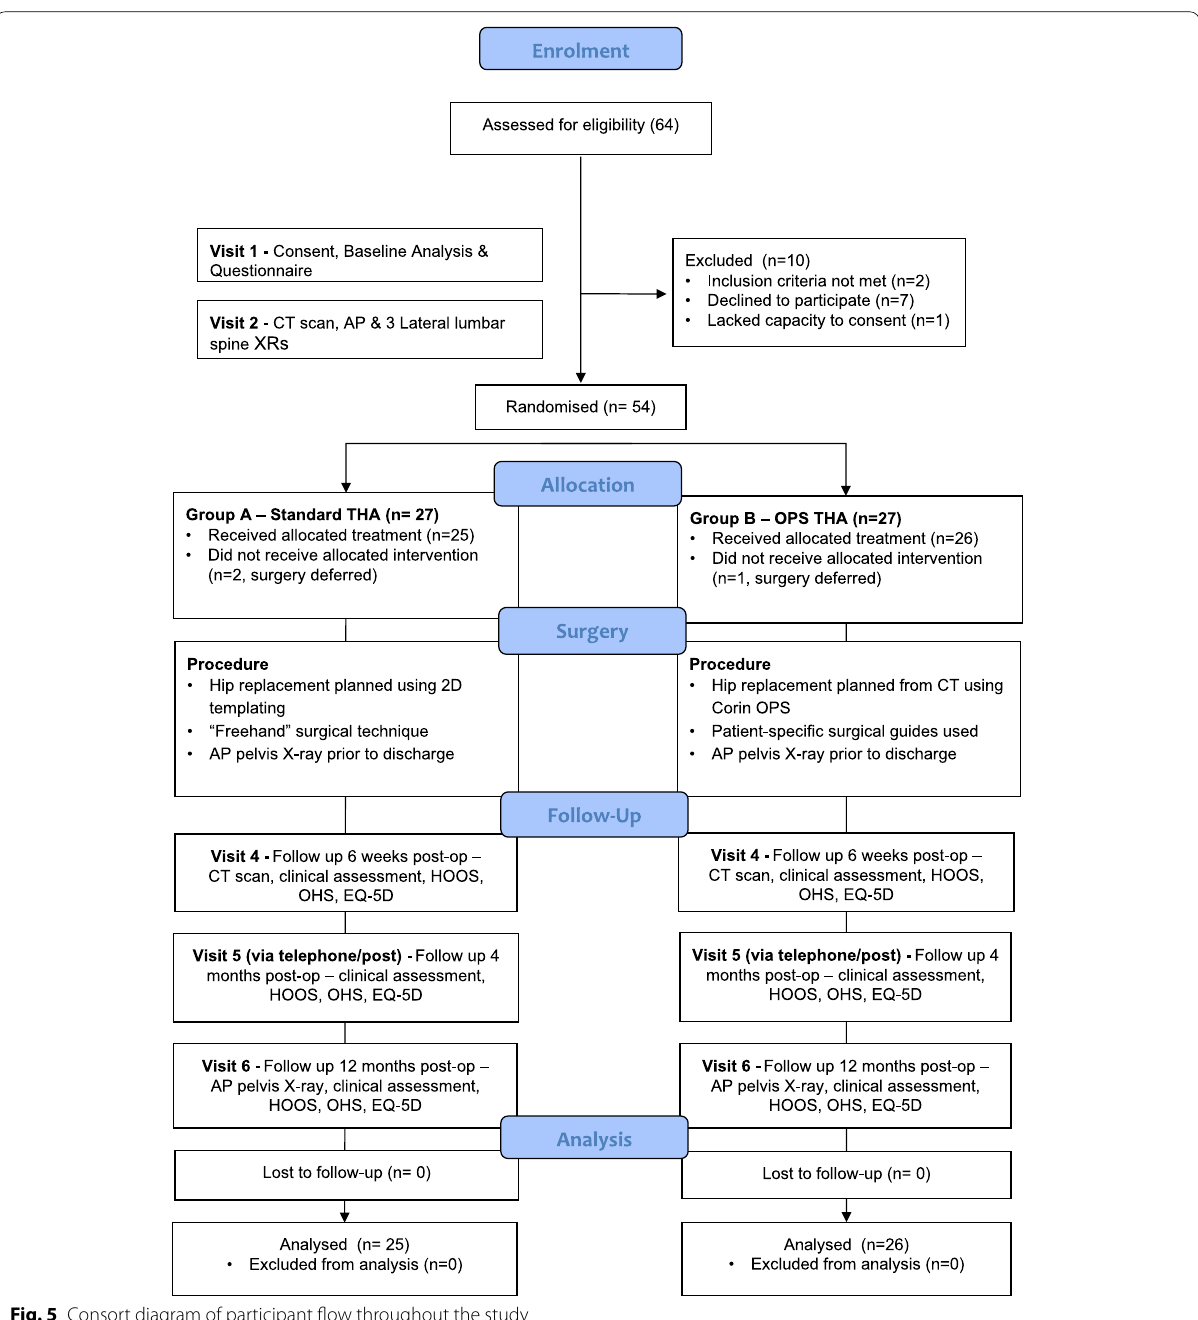
Fig. 5 Consort diagram of participant flow throughout the